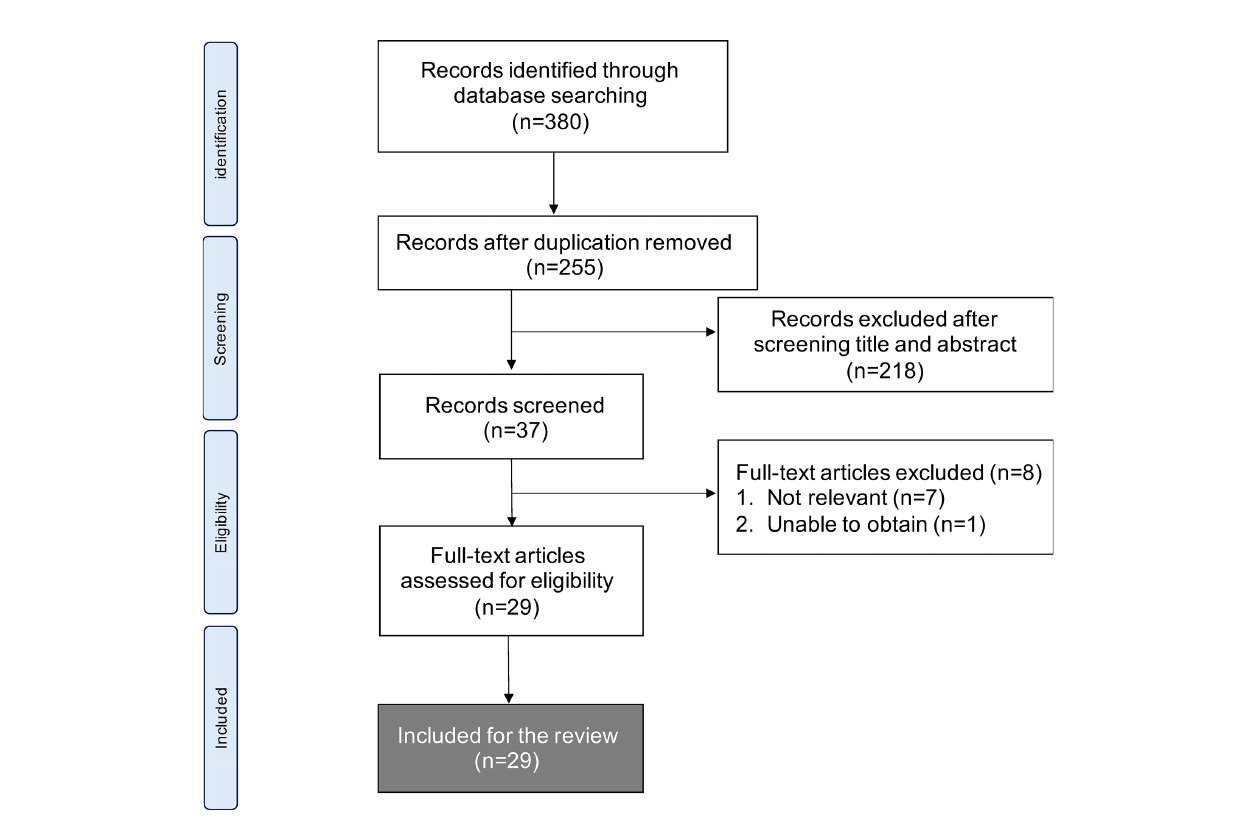
FIGURE 1 | Flow chart of methods used to conduct systematic literature review in accordance with PRISMA